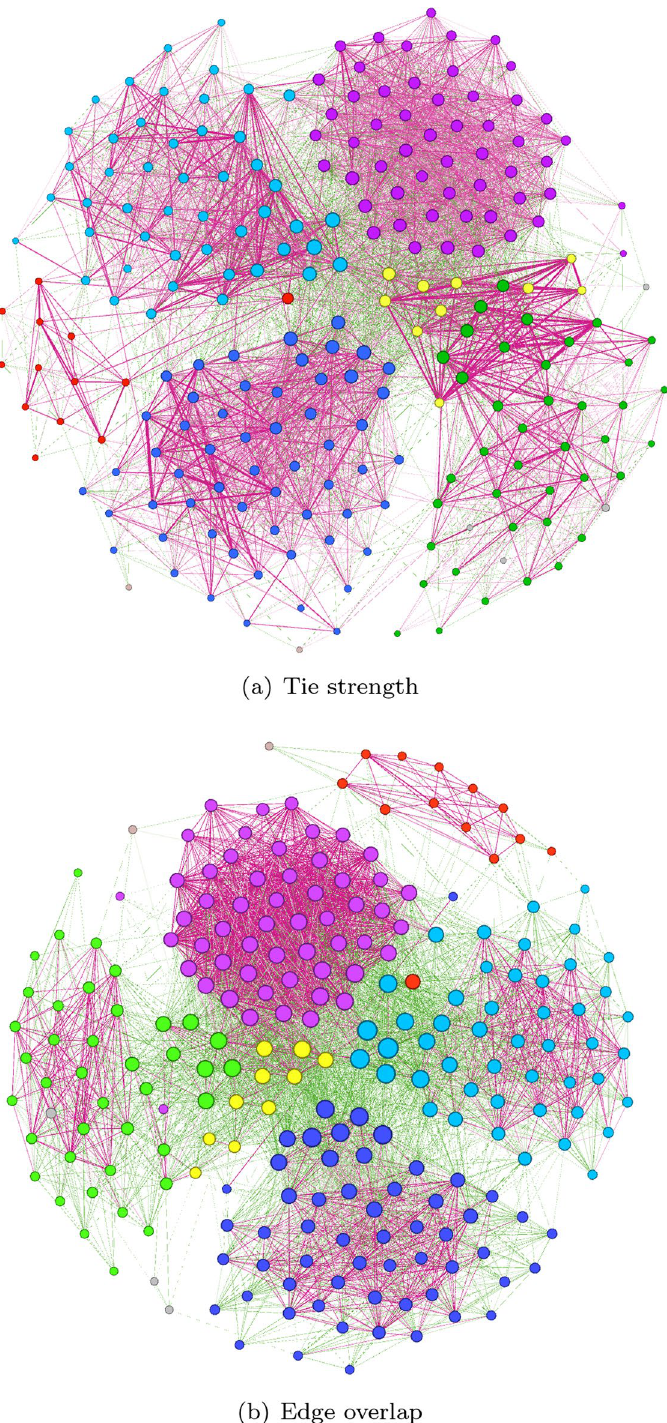
Fig. 3 Football network from 1995 to 2015 visualized via (Bastian et al. 2009). Edges with high tie strengths (total number of football games between two countries) or edge overlap (ratio of common neighbors of the two nodes connected by the edge) are colored in red while edges with low strengths or overlap are depicted in green. Both ( a ) and ( b ) show that most green edges are between confederations and red edges are within confederations. Each node color corresponds to one confederation. Purple: UEFA; Blue: CAF; Sky blue: AFC; Red: OFC; Green: CONCACAF; Yellow: